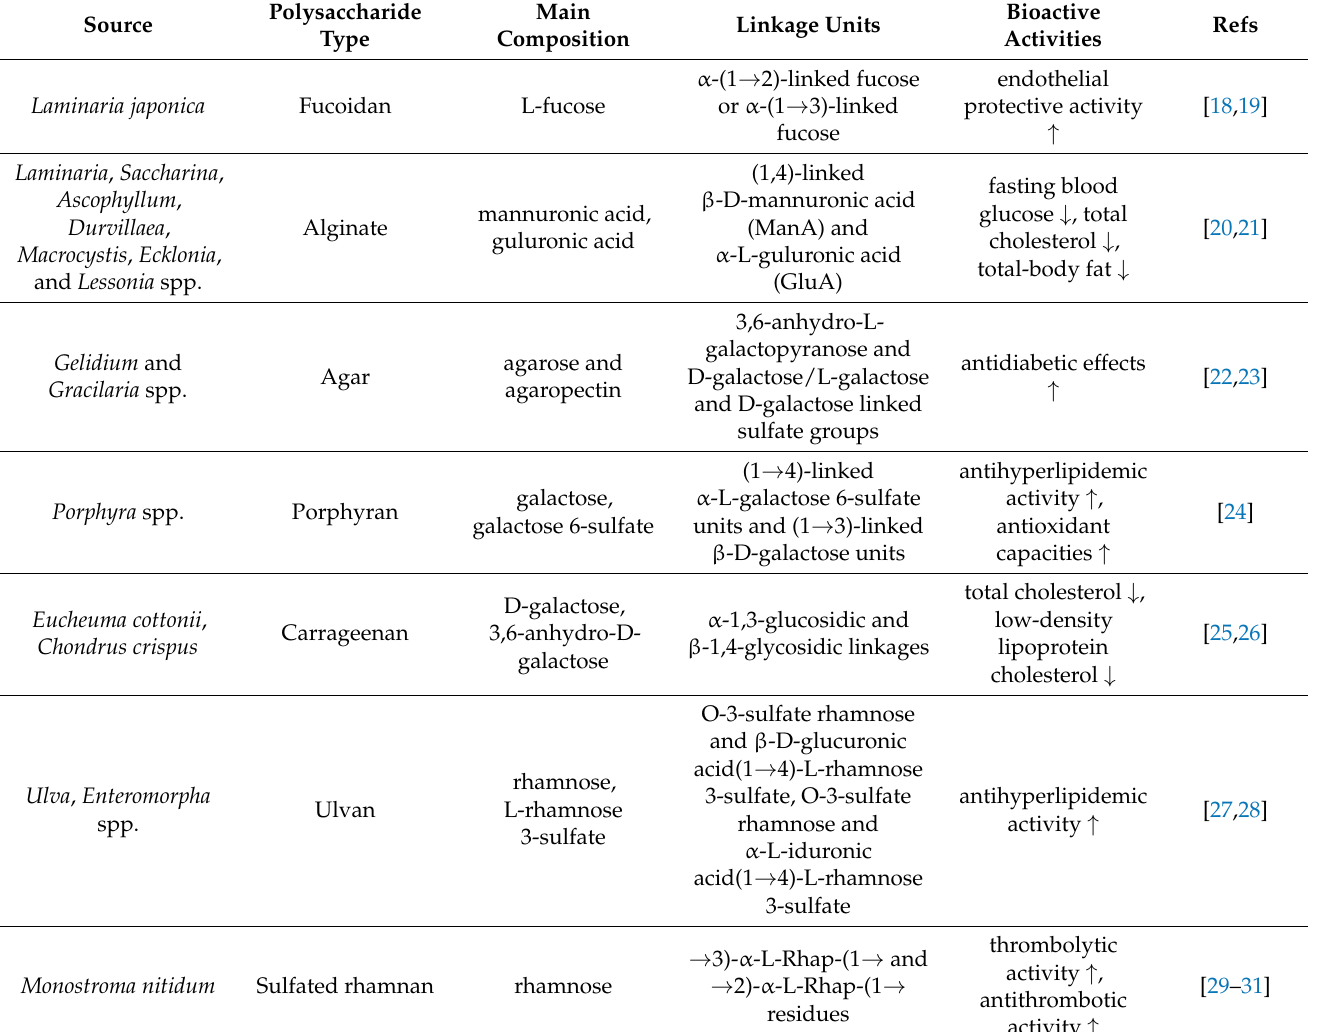
Table 1. Structural features and protective effects of polysaccharides from different marine